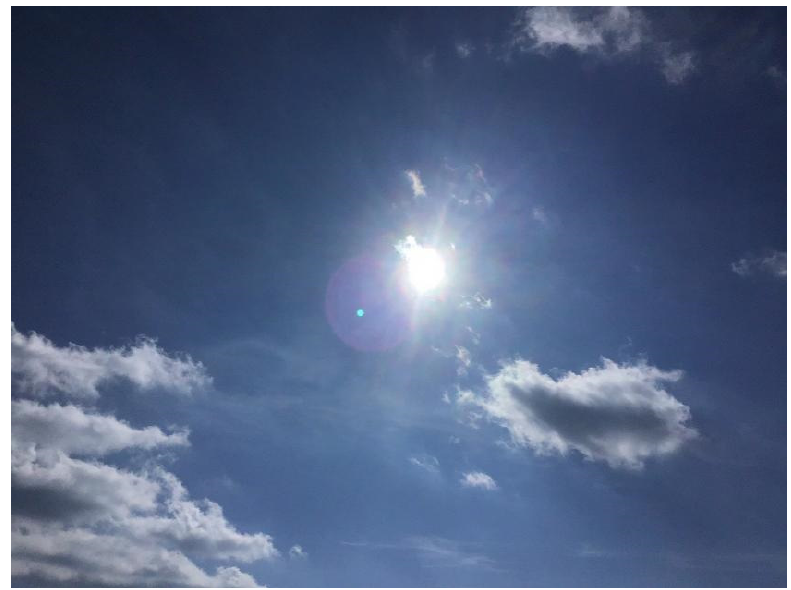
Figure 16. Weather at the time of the observation of December 3rd at 15:00.